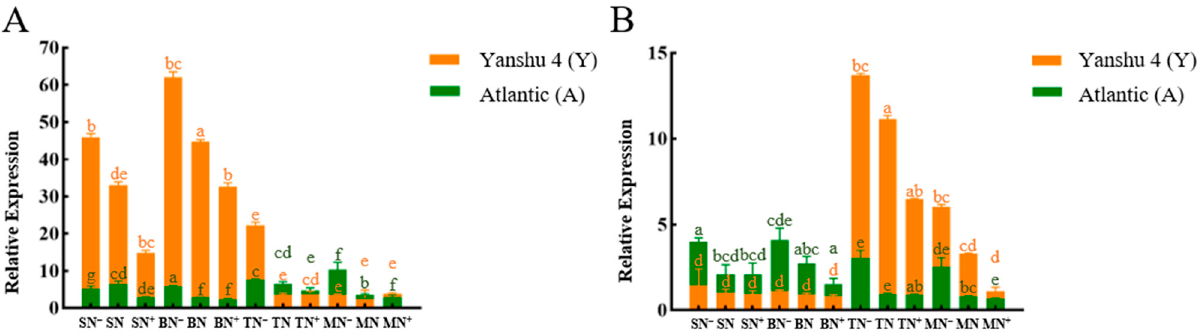
Figure 9. Relative expression of glutamate synthase gene StNADH-GOGAT in two genotypes of potato under different N supply levels. ( A ) Leaf (L); ( B ) Root (R). S, B, T, and M represent seedling stage, budding stage, tuber expansion stage, and mature stage, respectively. N − , N, N + are different N supply levels, representing low N, normal N, and excess N, respectively. Different letters indicate the difference of relative gene expression in different periods under different N application levels ( p < 0.05).